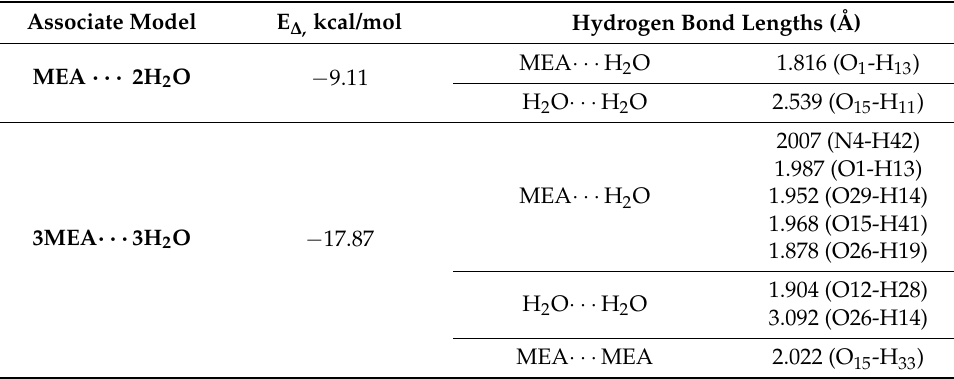
Figure 4. Structure of associate complexes: ( a ) MEA-2H 2 O, ( b ) 3 MEA-3H 2 O. Table 1. Hydrogen bond lengths and association energies in complexes Figure 4.